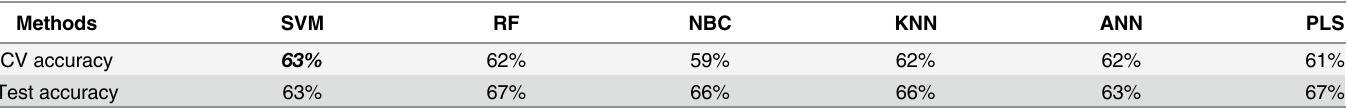
Table 6. dTm ternary